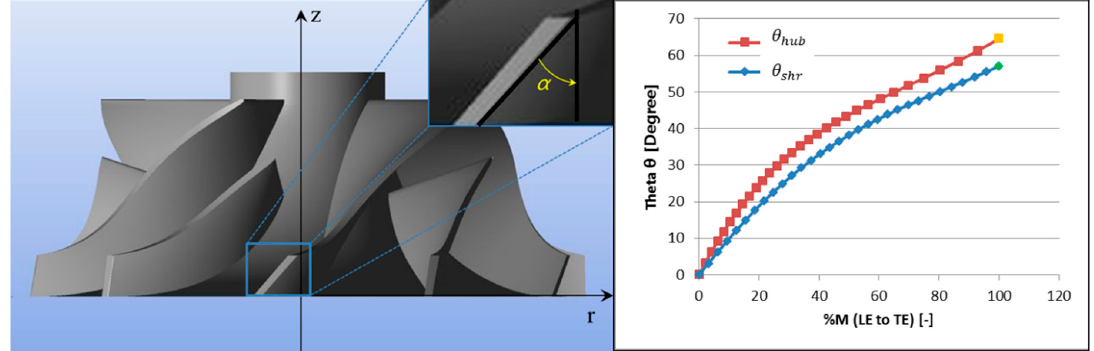
Figure 3. Definition of rake angle and illustration of theta angle distribution on the impeller.